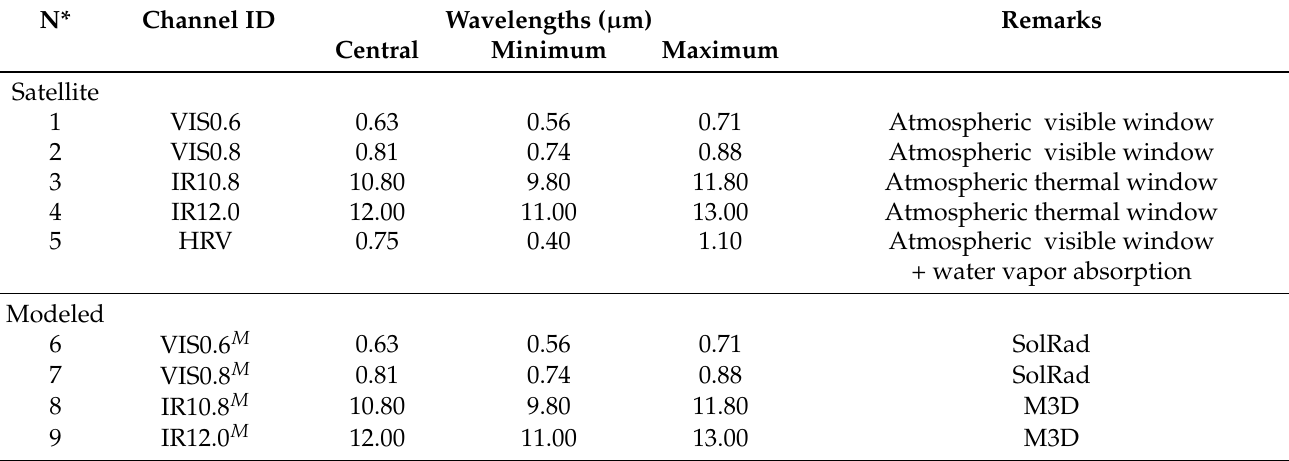
Table 1. SEVIRI and model spectral characteristics used in the